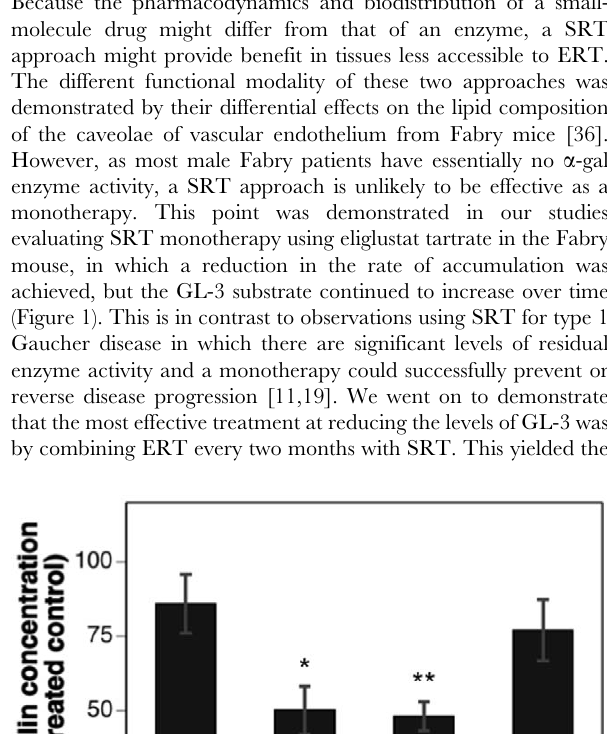
Figure 4. Combined enzyme-replacement therapy and substrate reduction therapy is most effective at reducing GL-3 levels in visceral tissues and fluids of the Fabry-Rag mouse. Untreated age-matched Fabry-Rag mice were used to standardize the GL-3 levels. ( A ) GL-3 levels over time for groups treated with ERT every two months ( % ),ERT every two months + eliglustat tartrate ( & ), ERT every four months + eliglustat tartrate ( # ) and eliglustat tartrate alone ( m ). ( B ) GL-3 levels at the end of the study in liver, kidney, heart (all 11-months old) and urine (10-months old) for groups treated with ERT every two months (ERT2), ERT every two months + eliglustat tartrate (ERT2 + SRT), ERT every four months + eliglustat tartrate (ERT4 + SRT) and eliglustat tartrate alone (SRT). Statistical comparisons are to the ERT2 treatment group. Data are shown as mean 6 SEM (n=5 mice/time point except 11-month tissue and all blood and urine samples where n=10 mice/time point). Statistics were determined using the Graphpad Prism software t test (*=p , 0.05; **=p , 0.01; ***=p ,